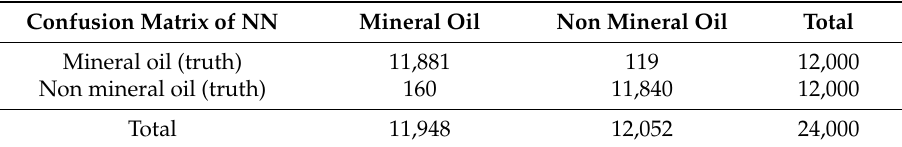
Table 9. SAE Confusion Matrix (20,000 training, 4000 testing, six-fold) derived by NN.